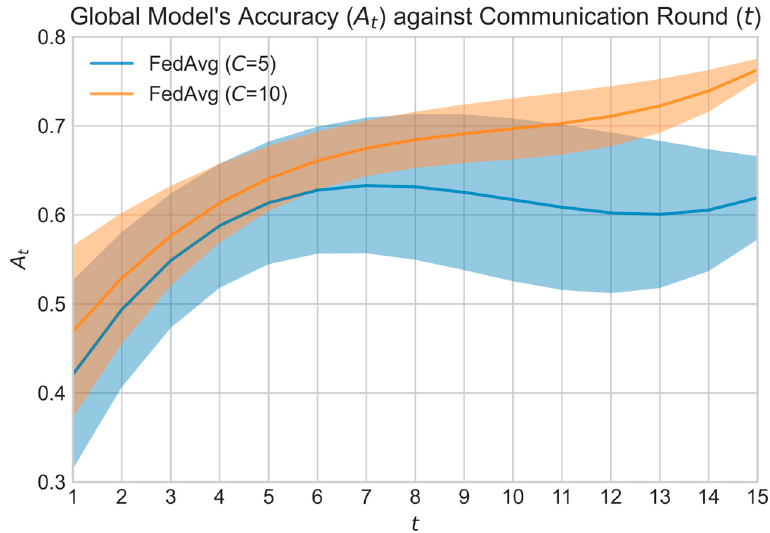
Figure 2. The global model’s accuracy curve for 𝐶 = 5 and 𝐶 = 10 .